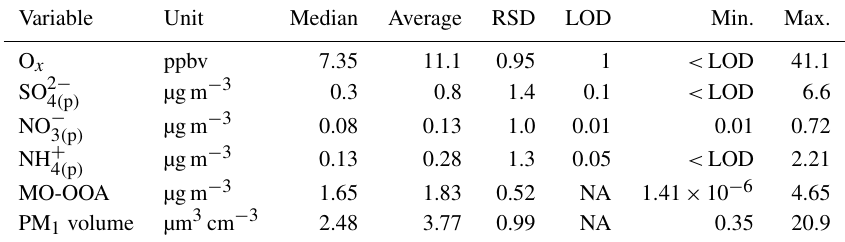
Table 4. Variables added in the second PCA. Particle-phase concentrations, i.e., SO 2 − aerosol mass spectrometry and account for PM 1